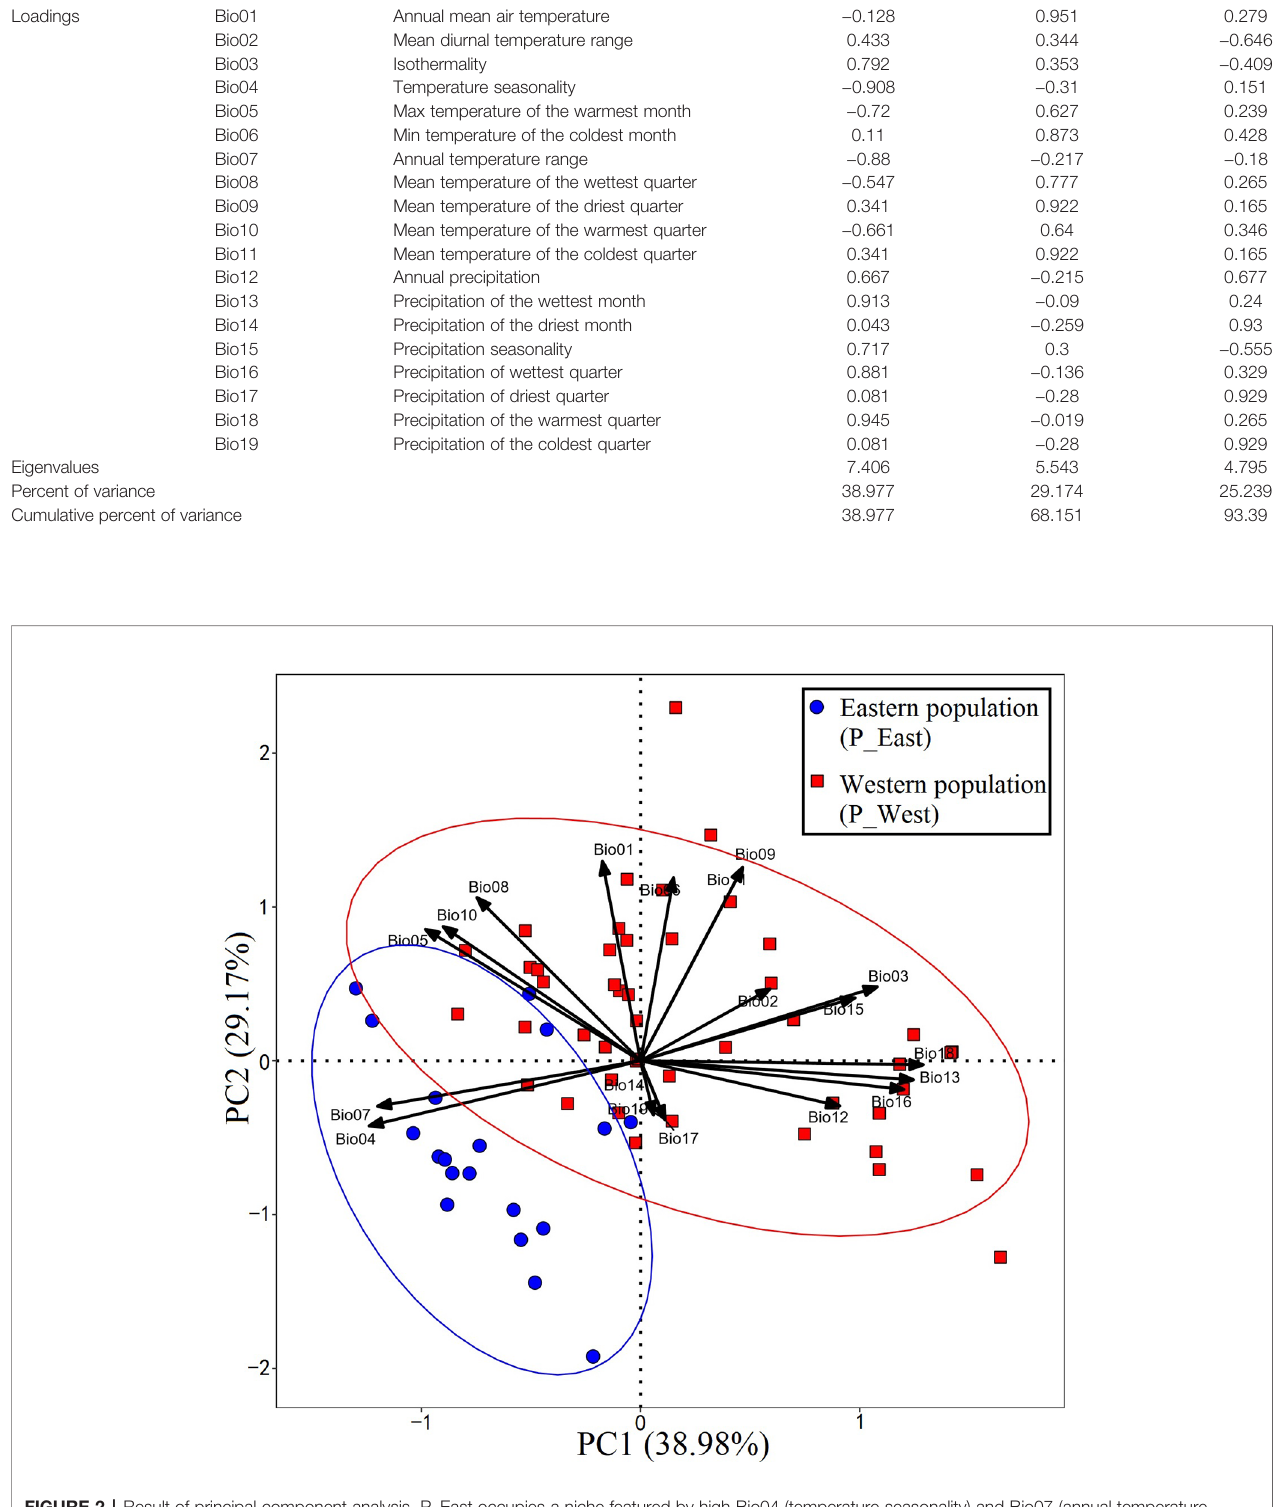
FIGURE 2 | Result of principal component analysis. P_East occupies a niche featured by high Bio04 (temperature seasonality) and Bio07 (annual temperature range), while P_West features high Bio09 (mean temperature of the driest quarter) and Bio11 (mean temperature of the coldest